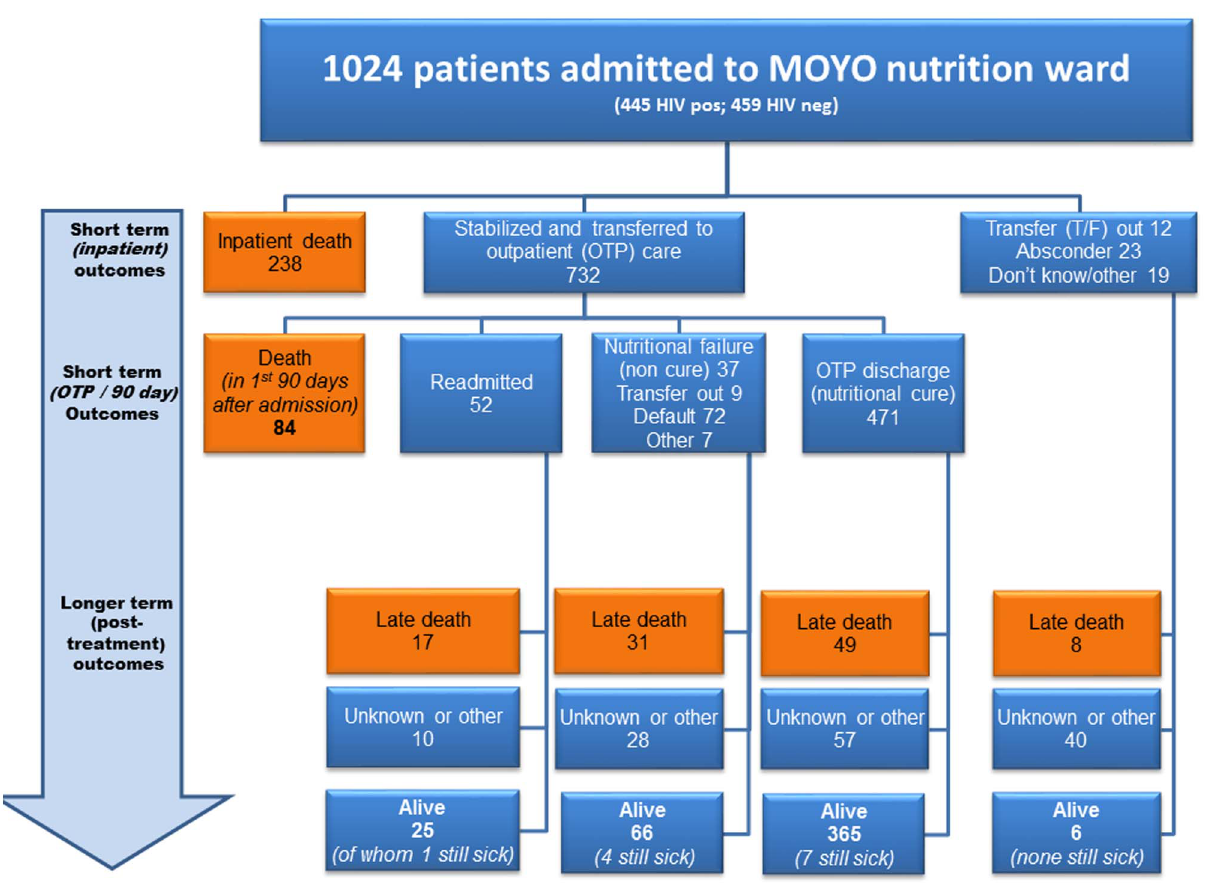
Figure 1. FuSAM study flow chart - all admissions to MOYO. (OTP=‘Outpatient Treatment Programme’ – the outpatient part of treatment; T/ F=transfer out to different programme). ‘Still sick’ children were seen or reported to be clinically unwell at follow-up but details were not always known.